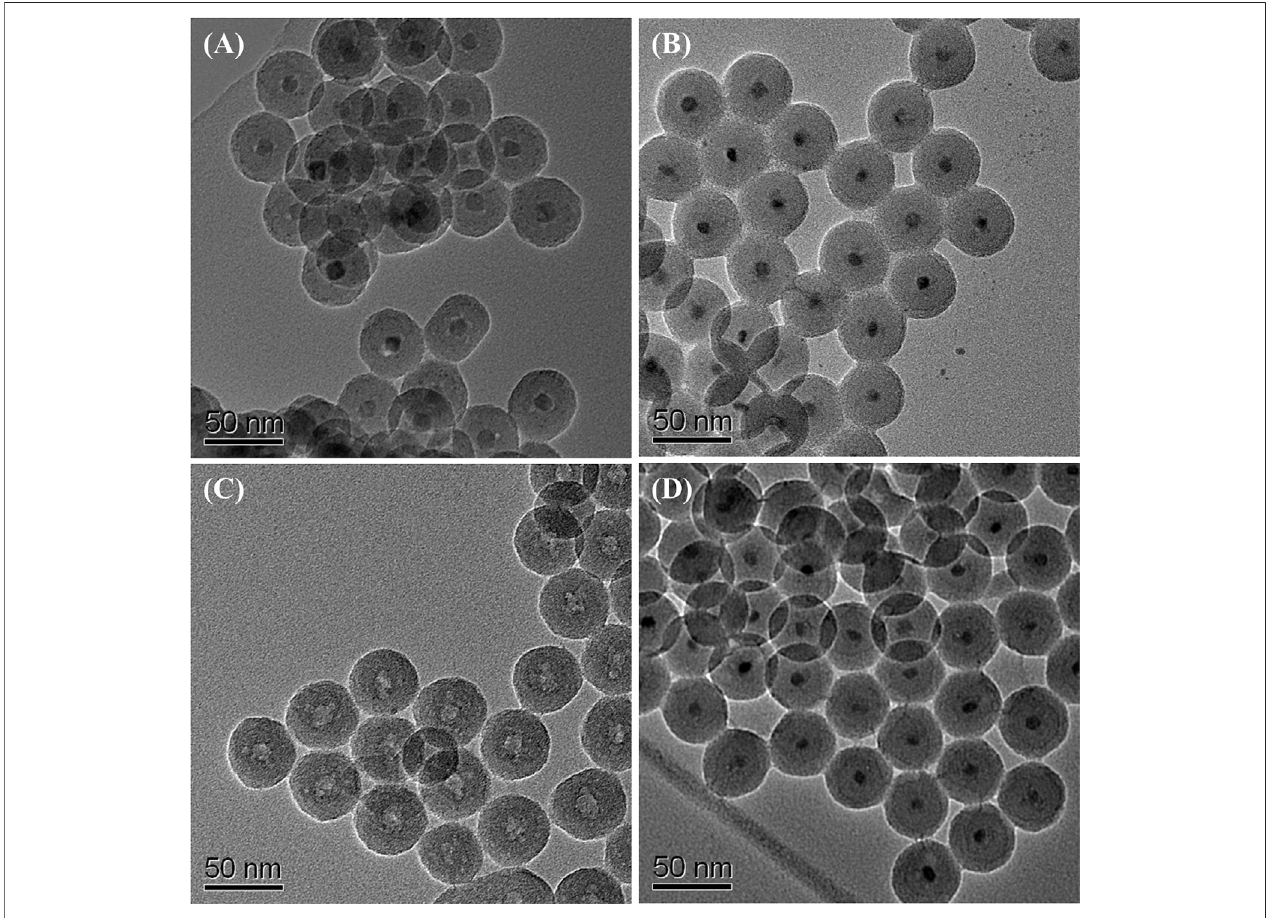
FIGURE 5 | TEM images of iron oxide at silica core/shell nanoparticles after etching with 3 M HCl for (A) 2 h, and (C) 24 h; iron nitride at silica core/shell nanoparticles after etching with 3 M HCl for (B) 2 days, and (D) 10 days.